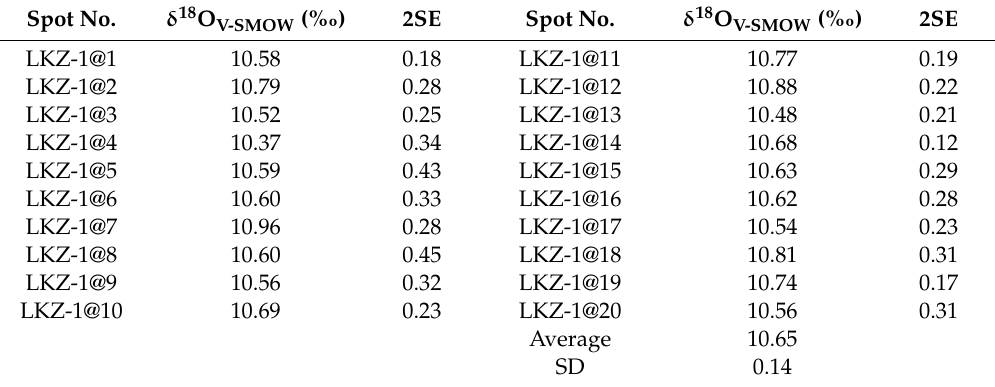
Table 5. HR-SIMS O isotopic results for the LKZ-1